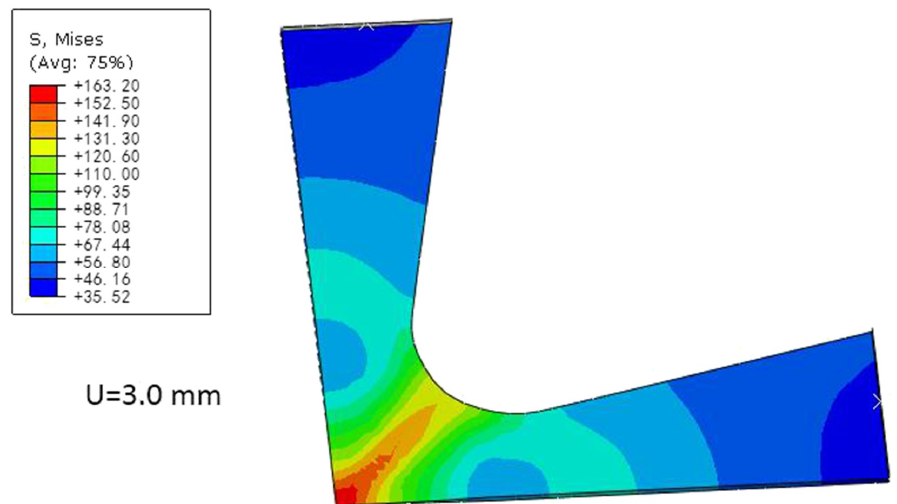
Figure 14. FE simulation result of cruciform specimen.